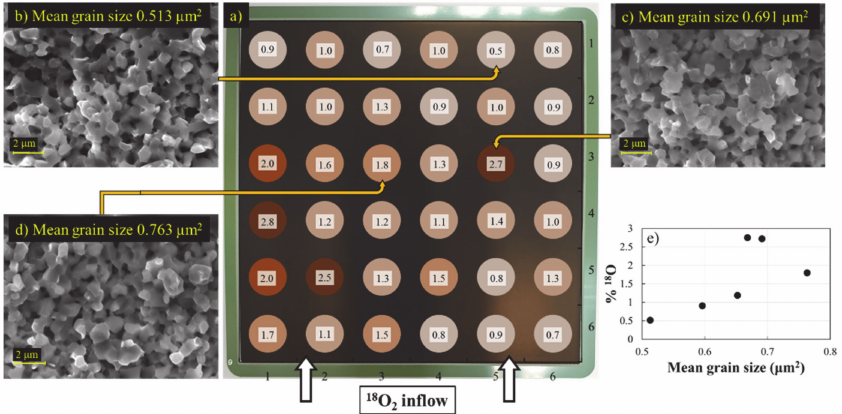
Figure 10. Composite figure of data gathered from the 860-h long SOEC test containing ( a ) the 18 O ratio map created from ToF-SIMS data from the active Ni-YSZ fuel electrode, ( b – d ) HR-SEM pictures from near some more interesting sites with calculated mean Ni-YSZ grain sizes and ( e ) correlation between measured mean grain sizes and 18 O ratios at certain